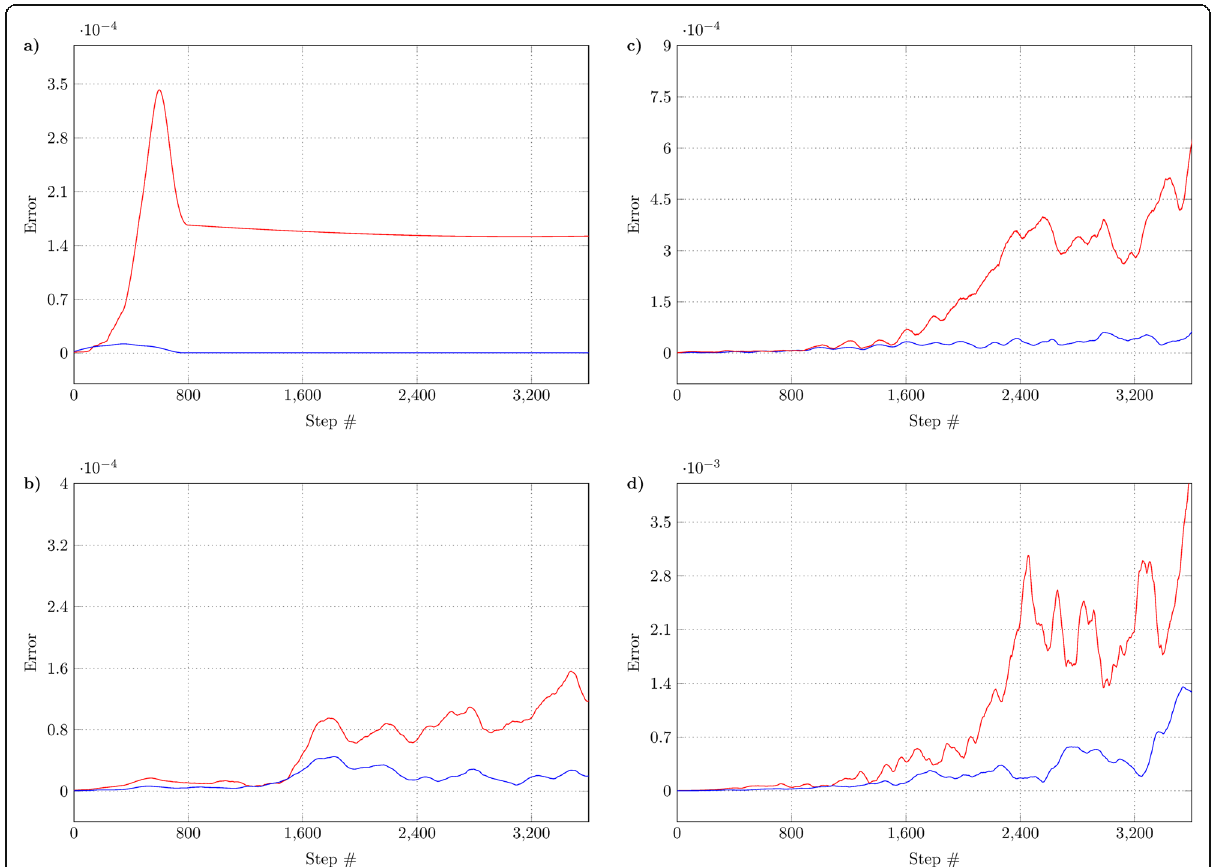
Fig. 2 Precision measurements. The blue line marks the precision of the approach based on barycentric coordinates, while the red line marks the precision of the method using matrix transformations. Each measurement differs in the type of movement: a seldom-changing constant direction, b spiral movement, c constant direction with randomly generated rotations, and d randomly generated rotations and translation vectors